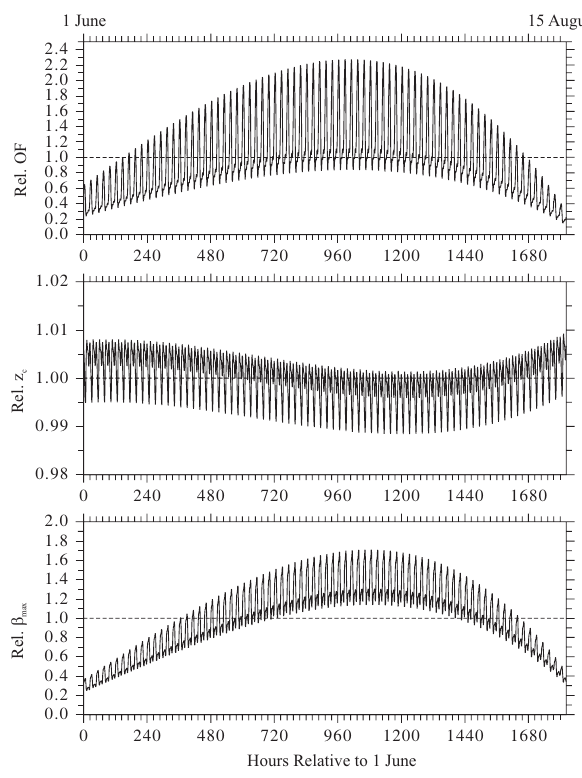
Fig. 2. Hourly relative variations of NLC occurrence (top), altitude (middle) and brightness (bottom) as determined from fit coefficients for the integrated ALOMAR RMR-lidar data set from 1997 to 2010. For details see text. In Fig. 4 the local time variations are shown with higher